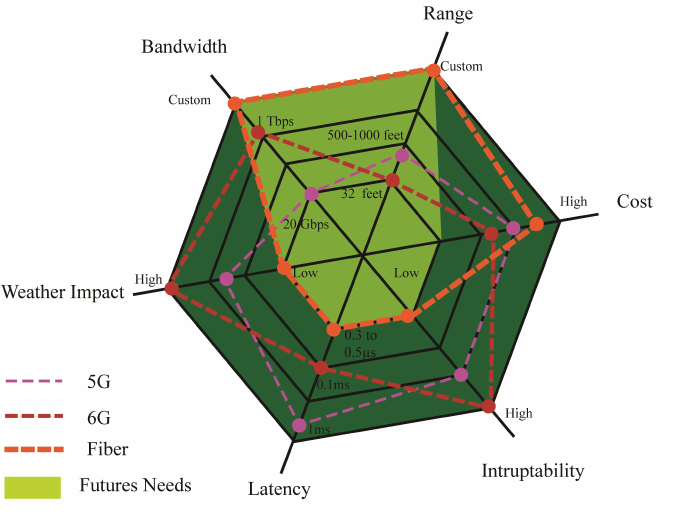
Figure 17. Backhaul links and future